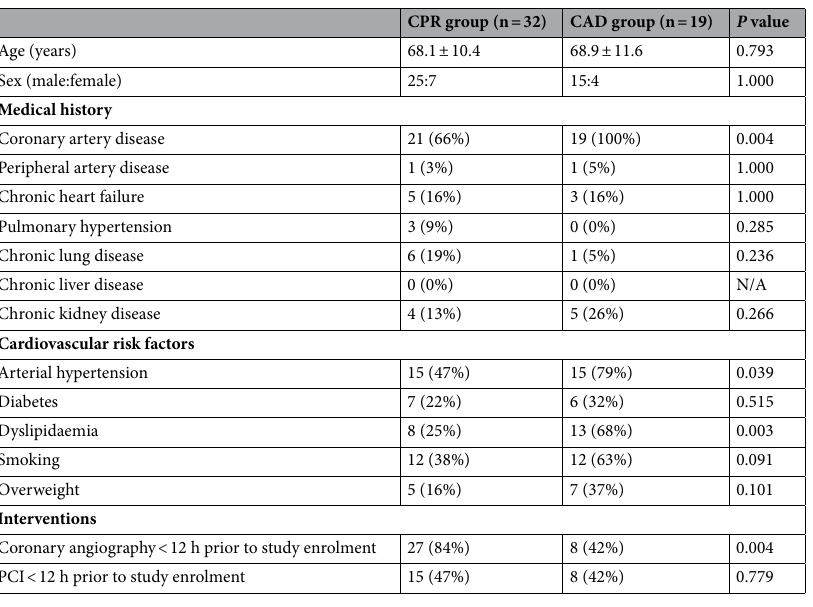
Table 1. Baseline patient characteristics. CPR cardiopulmonary resuscitation, CAD coronary artery disease, PCI percutaneous coronary intervention, N/A not